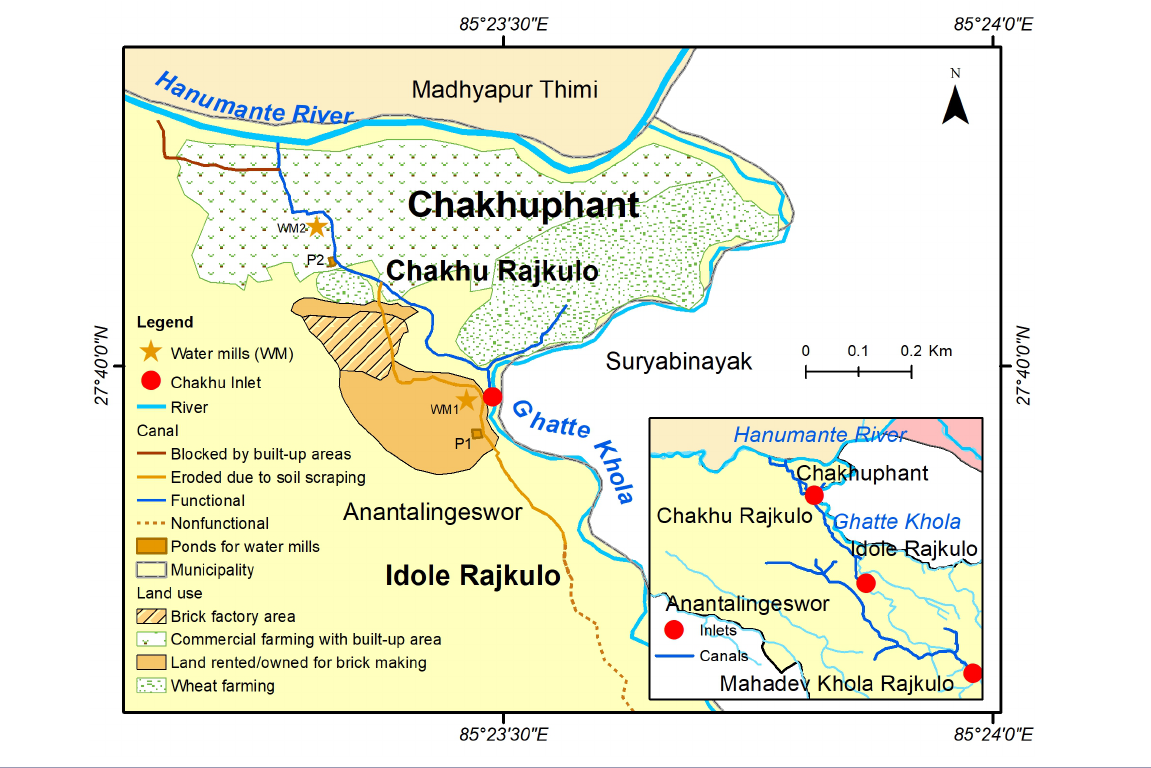
Fig. 2 . Three rajkulos fed by Ghatte Kholo, the water structures and canal sections that existed in the past and that still exist in